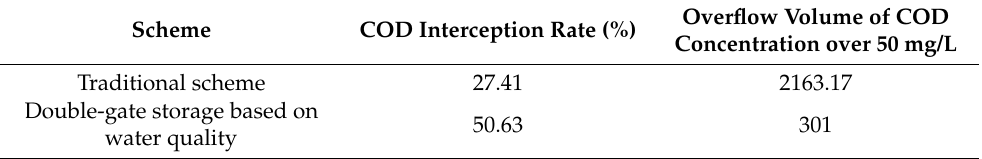
Table 5. The comparison of two schemes.